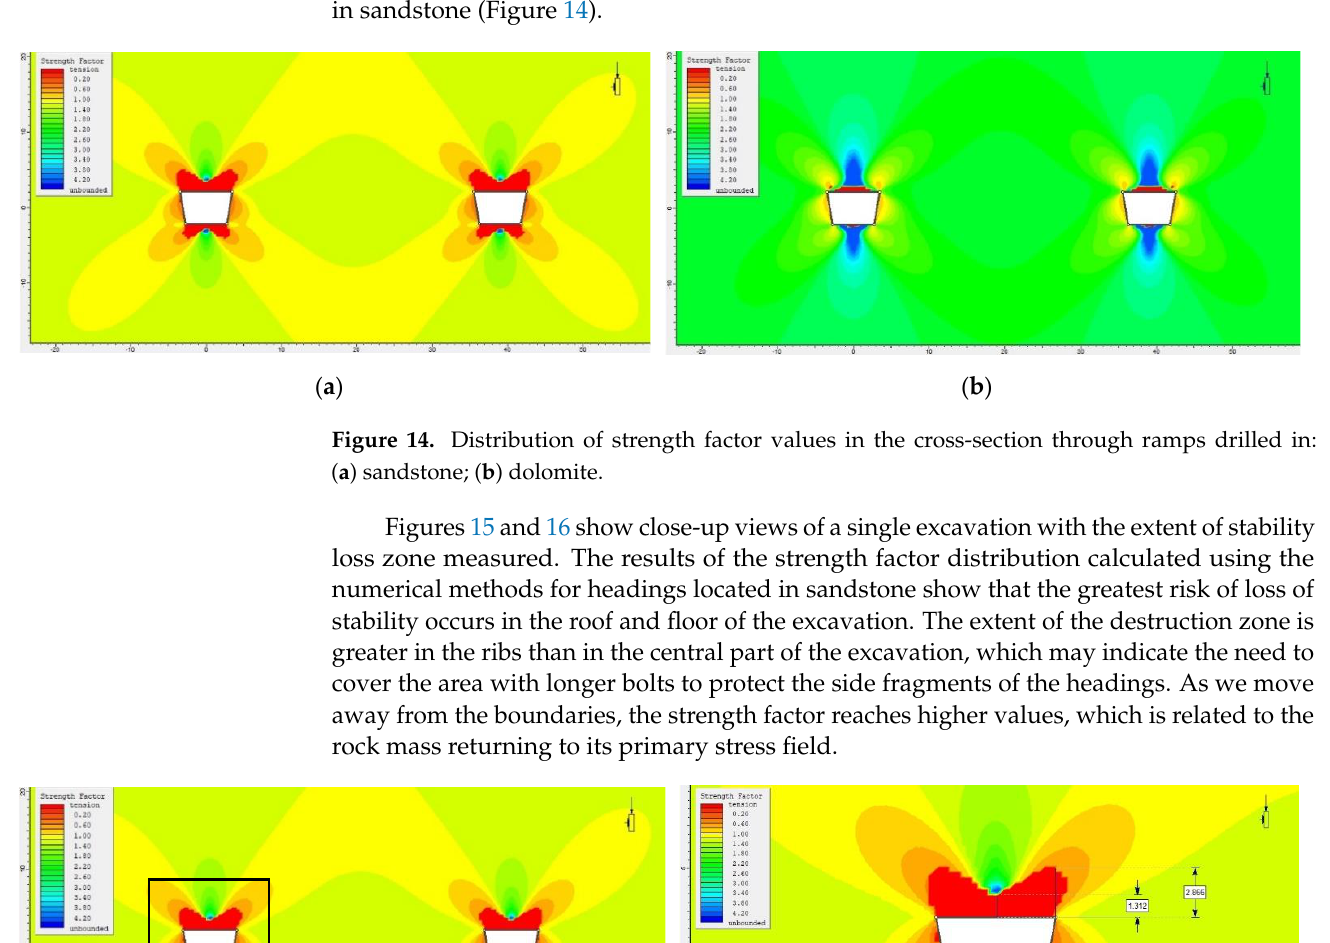
Figure 16. Distribution of strength factor values in the cross-section through ramps drilled in dolomite: ( a ) view of both headings; ( b ) close-up of a single excavation.